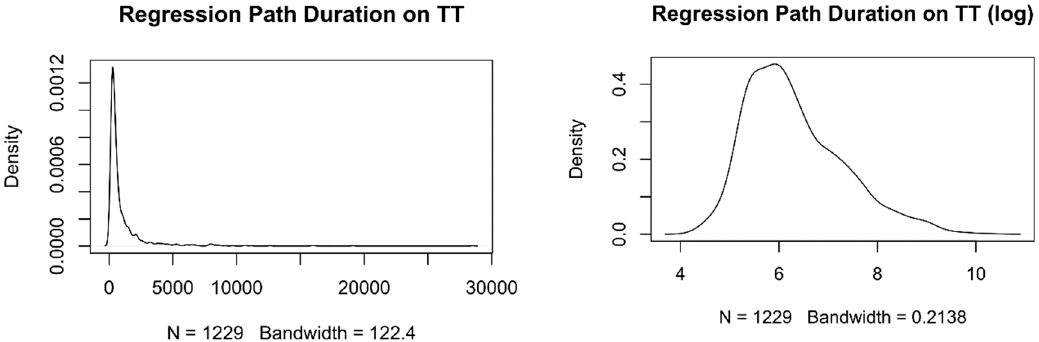
Figure 10. Density plot ( left ) and log-transformed density plot ( right ) for regression path duration on TT.